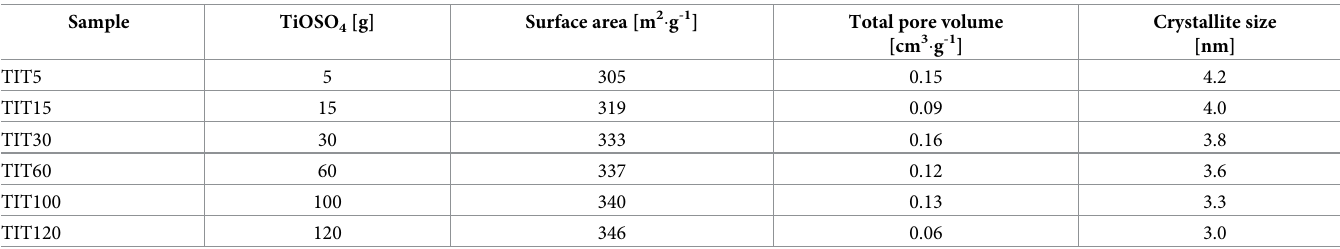
Table 1. Specific surface area, total pore volume, and the crystallite size of TiO 2 samples prepared by homogeneous precipitation.